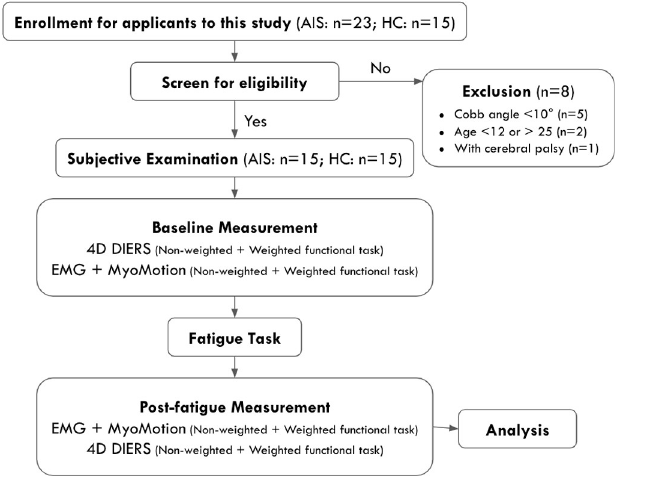
Fig 2. Flow chart of experimental